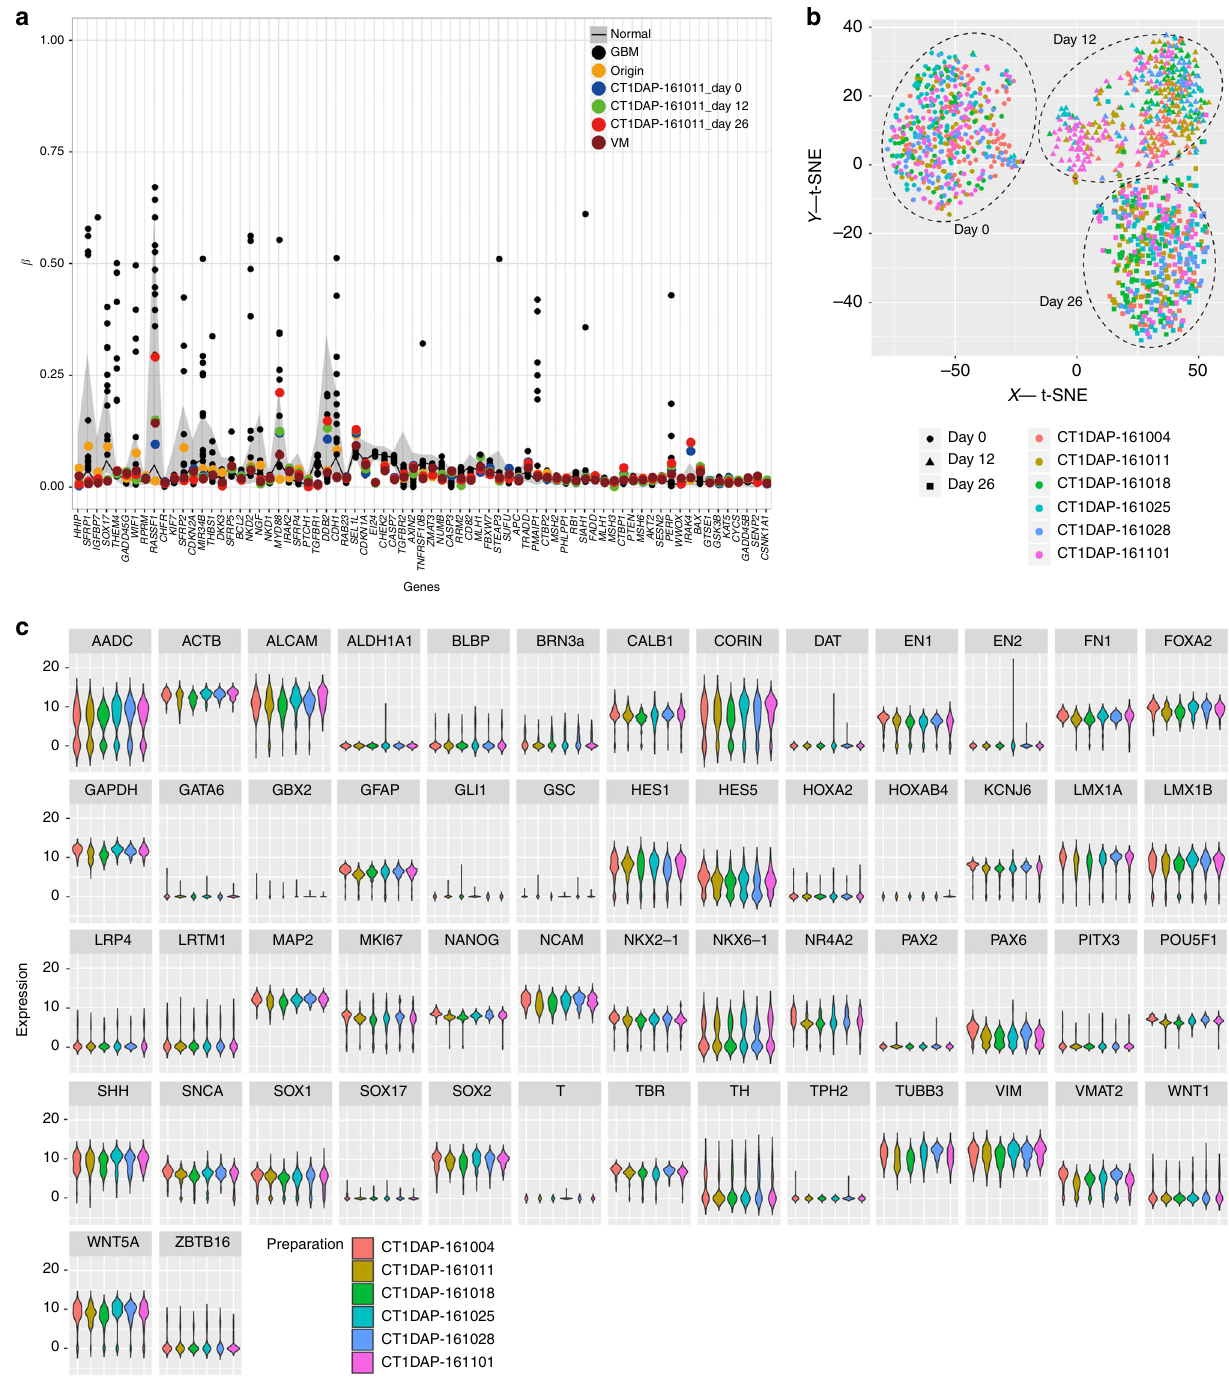
Fig. 2 Genome/epigenome analysis and single-cell-based gene expression analysis. a Representative results of the methylation array analysis of the DAPs (cell preparation: CT1DAP-161011) used in the tumorigenicity study. b A t-SNE plot of the single-cell data of the six lots tested in the tumorigenicity study. Each lot contains undifferentiated cells (day 0), intermediates (day 12), and the fi nal product (day 26). c Violin plots of the expression pattern in DAPs from the six tested lots in the tumorigenicity study by single-cell RT-qPCR. GBM glioblastoma multiforme, VM ventral